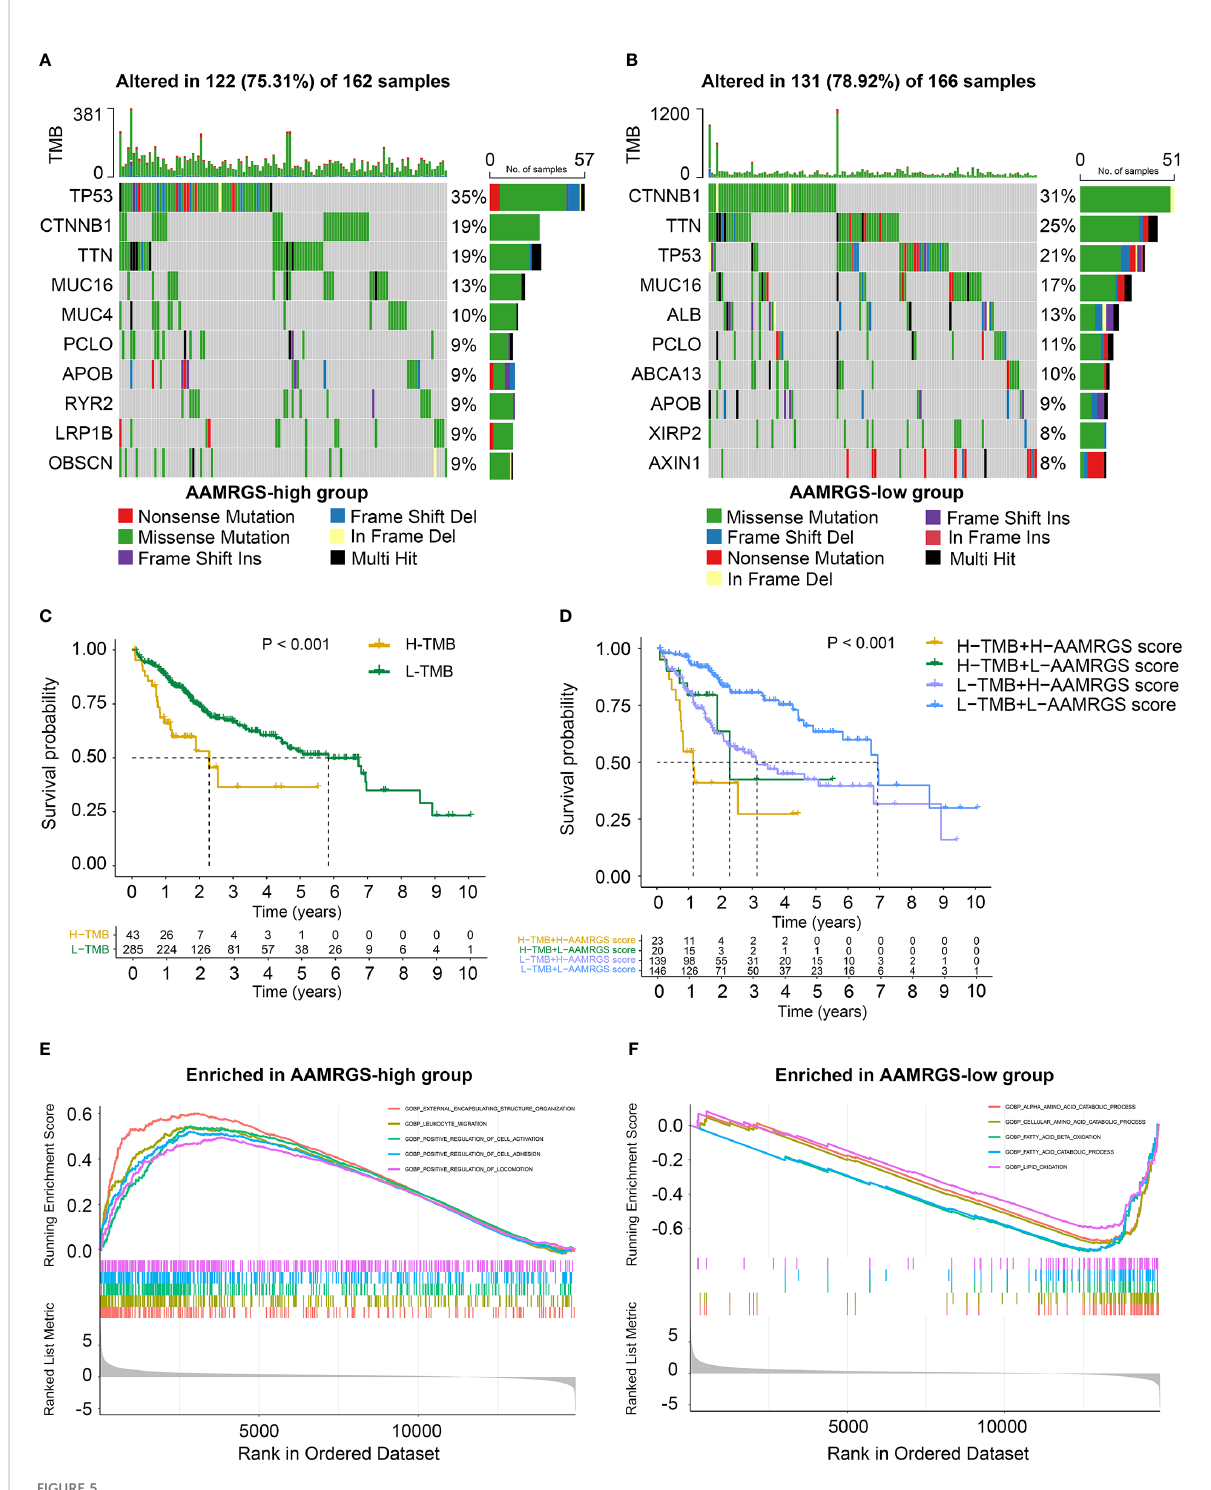
FIGURE 5 Mutational landscape and biological characteristics in the AAMRGS-high and AAMRGS-low groups. (A) Top 10 genes with high mutation probability in the AAMRGS-high group. (B) Top 10 genes with high mutation probability in the AAMRGS-low group. (C) KM survival analysis of the TMB. (D) In fl uence of the AAMRGS score combined with TMB on OS. (E) Enrichment of gene sets associated with biological processes in the AAMRGS-high group. (F) Enrichment of gene sets associated with biological processes in the AAMRGS-low